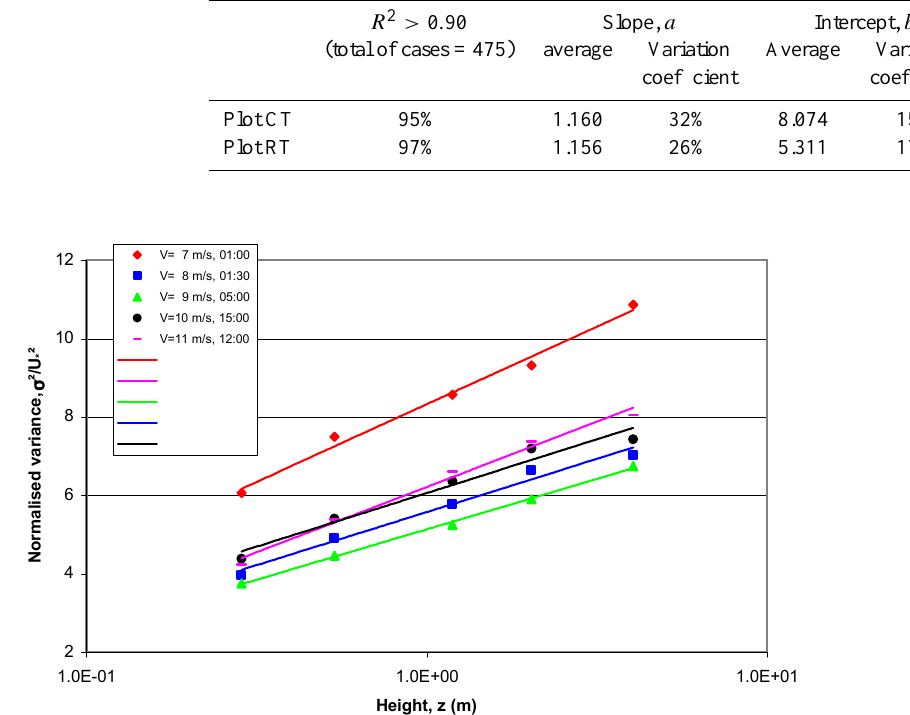
Fig. 4. Normalized variance ( σ 2 u /U 2 ∗ ) as a function of the height logarithm, ln (z) , for various wind velocity (7 to 11m/s) and at different daytime (01:00 to 12:00LT) (Plot RT, level 5, 25 July